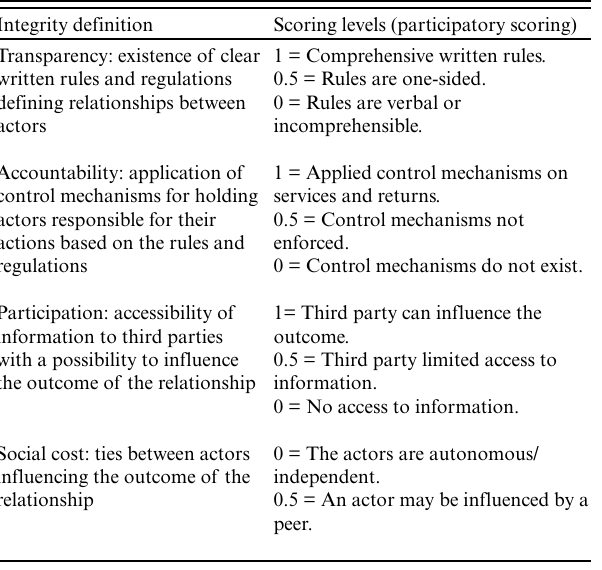
Table 1 . Integrity definitions and levels.